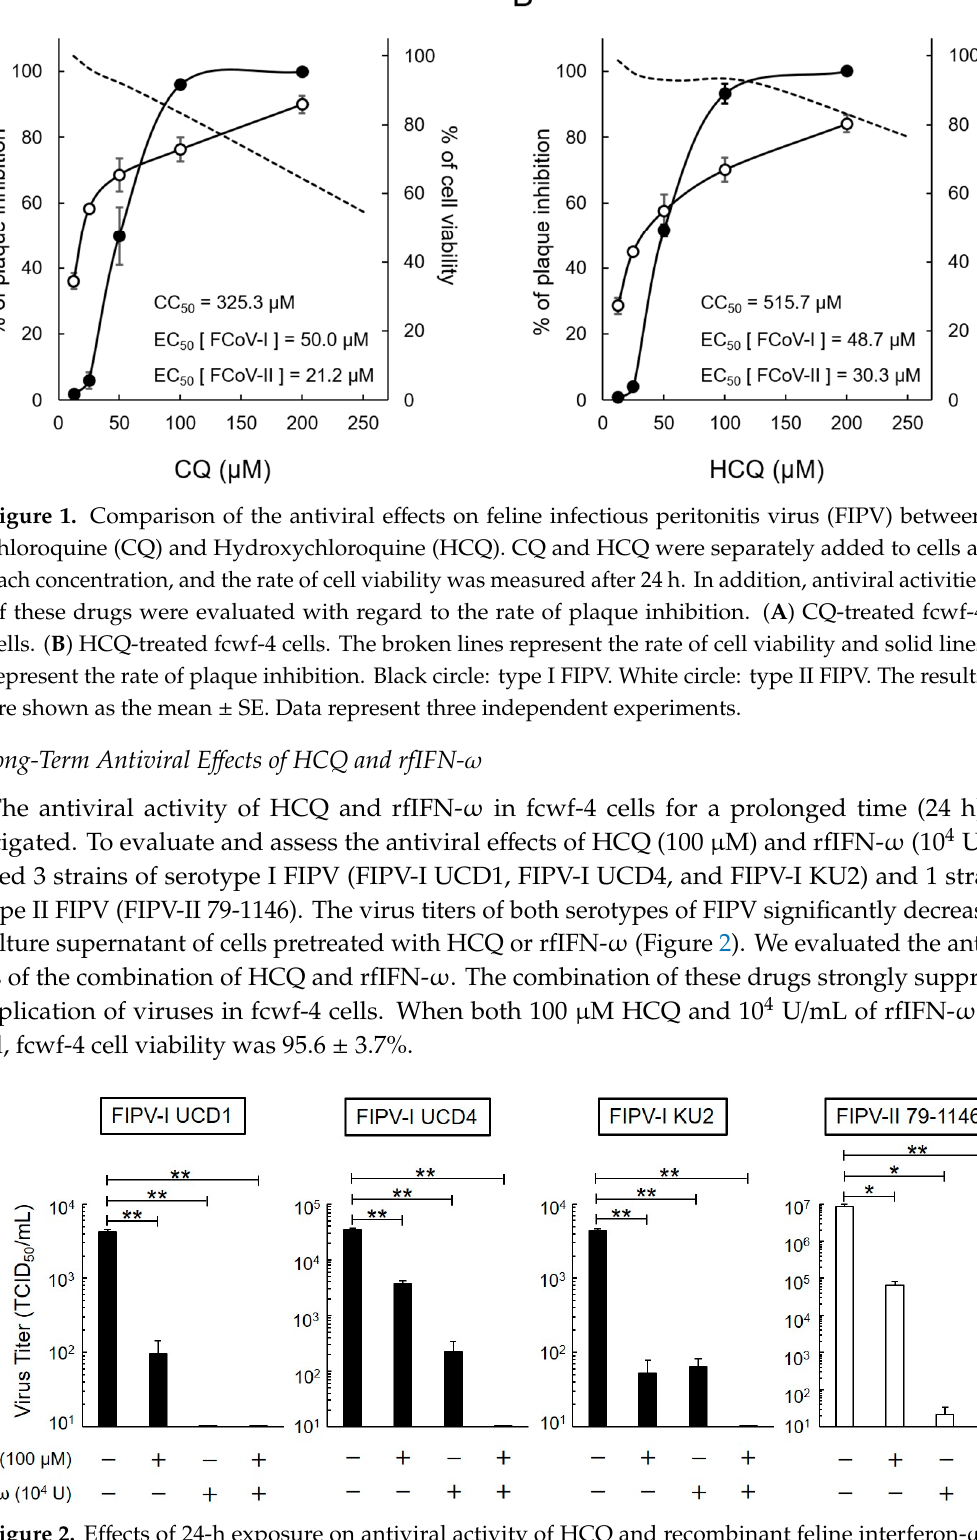
Figure 2. Effects of 24-h exposure on antiviral activity of HCQ and recombinant feline interferon- ω (rfIFN- ω ). Virus titer of FIPV-infected fcwf-4 cells pre-treated with HCQ (100 μ M) and rfIFN- ω (10 4 U/mL) for 24 h. The results are shown as the mean ± SE. Data represent four independent experiments. ** p < 0.01 (* p < 0.05) vs. untreated (pre-treated with medium only).